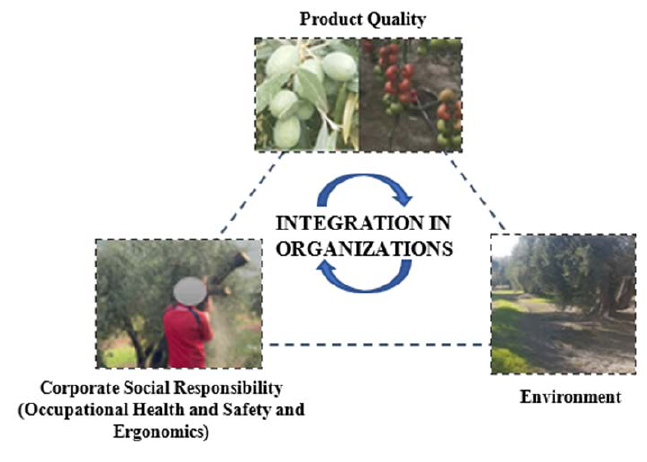
Figure 1. Triangle of sustainability